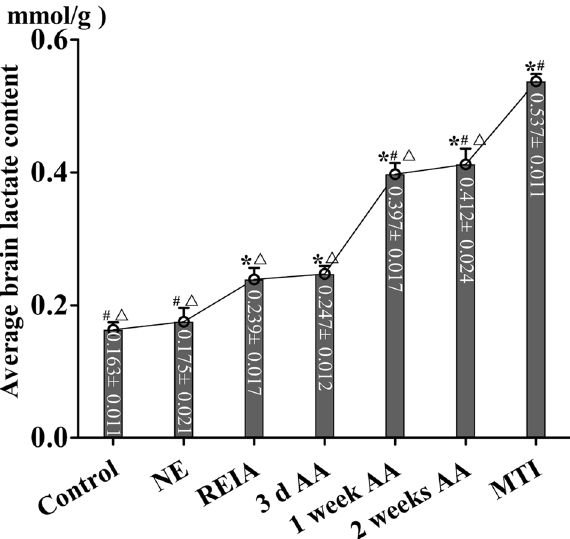
Figure 5. Average lactate content (in mmol/g) of rat brains in each group. Data are presented as the mean ± SD. *P < 0.05 vs. the NE group, #P < 0.05 vs. the REIA group, △ P < 0.05 vs. the MTI group (ANOVA with post hoc Bonferroni correction; n = 3 per